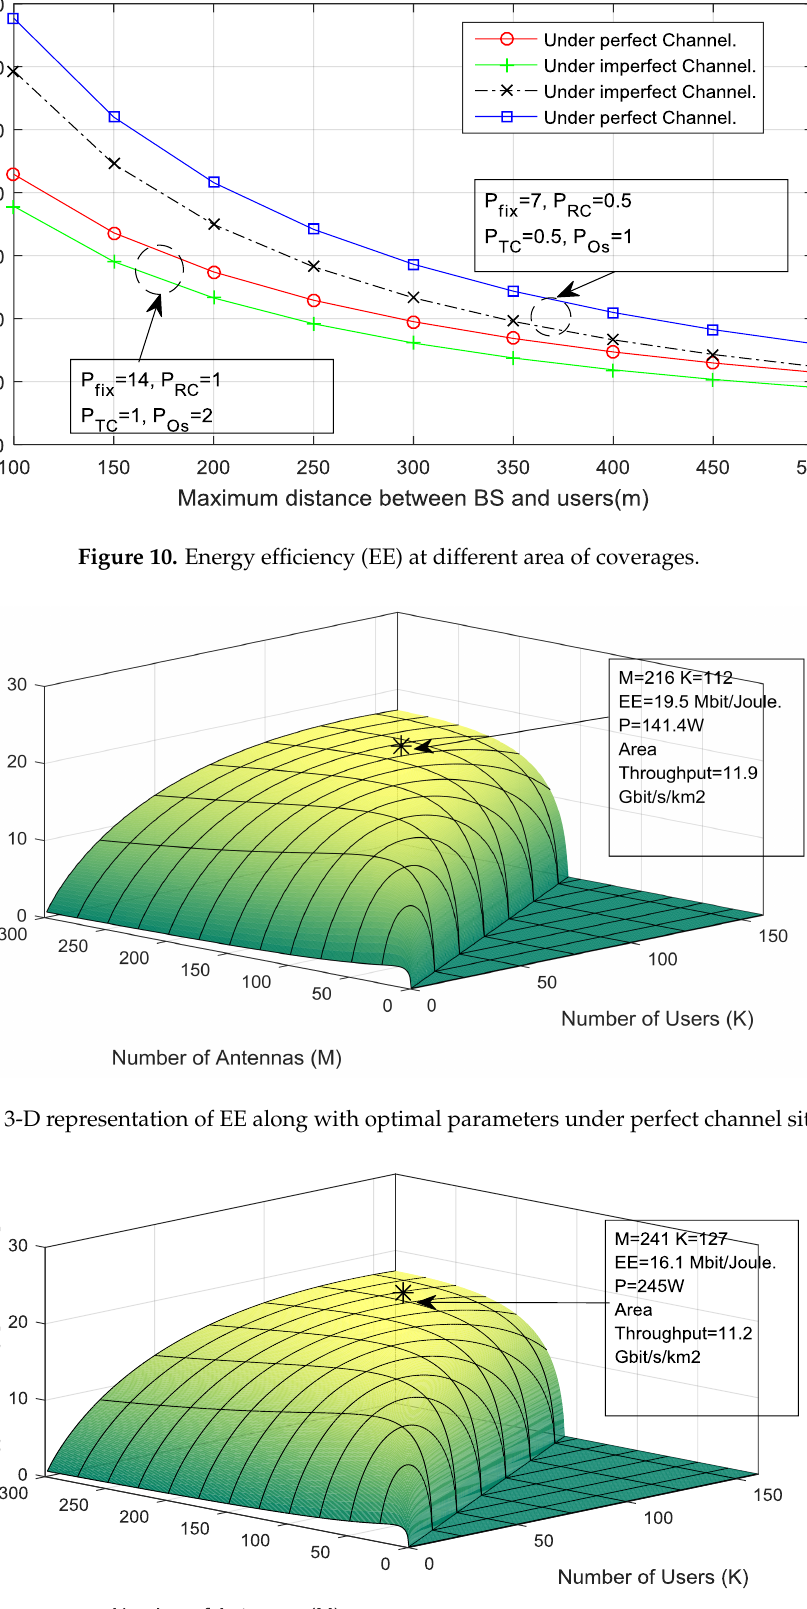
Figure 12. 3-D representation of EE along with optimal parameters under Imperfect channel situation.